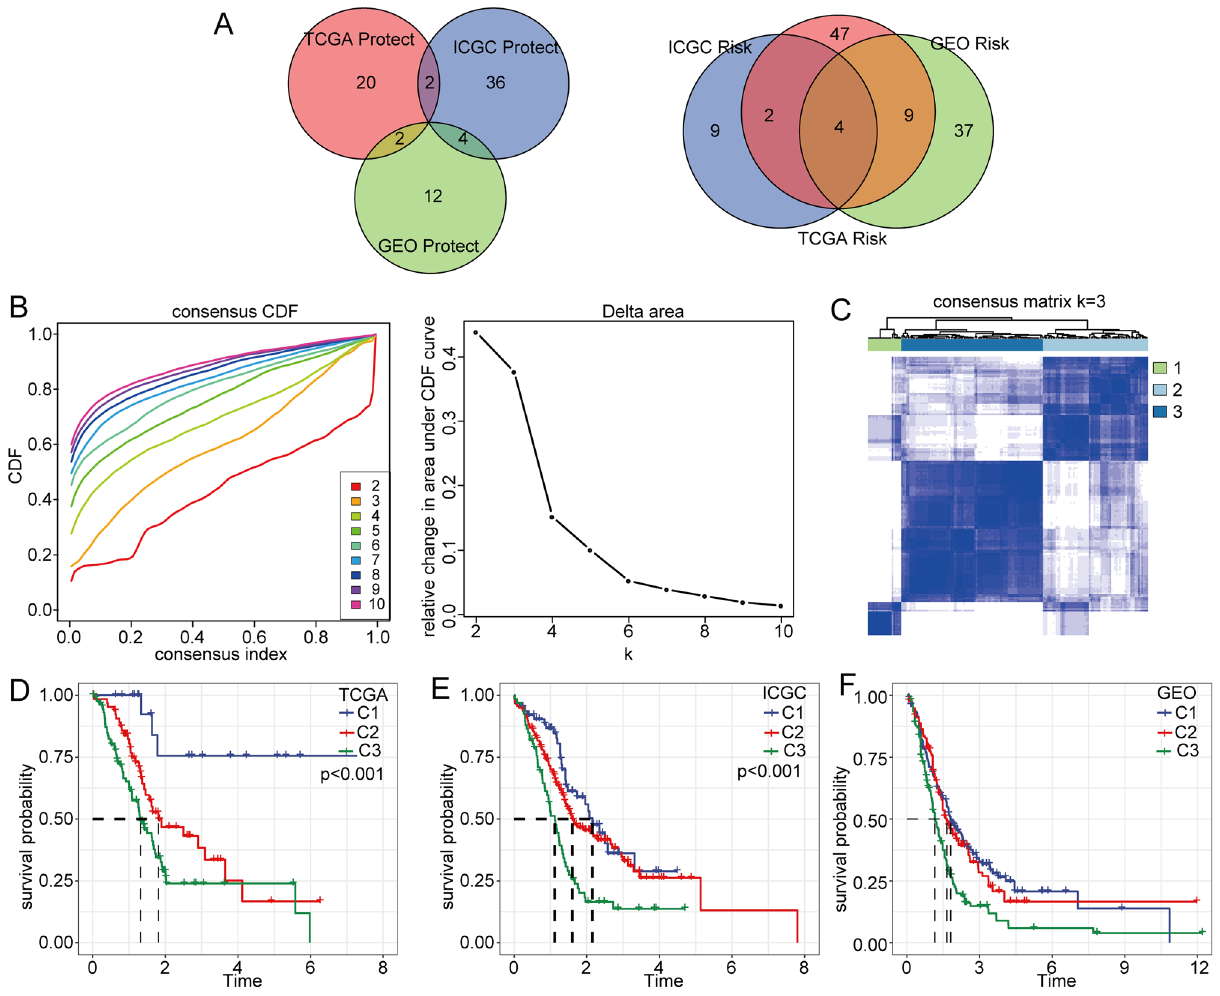
Figure 3. Construction of prognostic molecular clusters based on epi-PCGs. ( A ) Venn diagram of prognostic- related genes screened by univariate Cox regression analysis. ( B ) CDF curve of samples from the TCGA-PACA cohort and CDF delta area curve, delta area curve of consensus clustering. ( C ) Sample clustering heatmap when consensus k = 3. Survival analyses for the three clusters based on patients with pancreatic cancer from TCGA dataset ( D ), ICGC dataset ( E ), and GEO dataset ( F